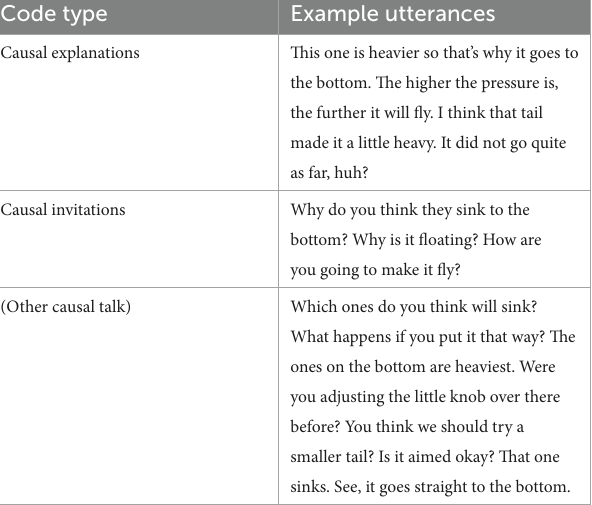
TABLE 4 Parent causal talk: example utterances for code types. Code